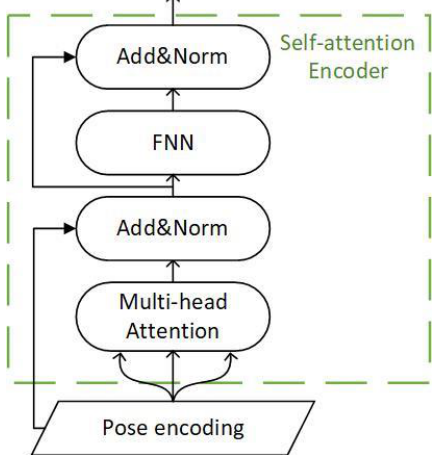
Figure 5. The structure of the self-attention encoder.